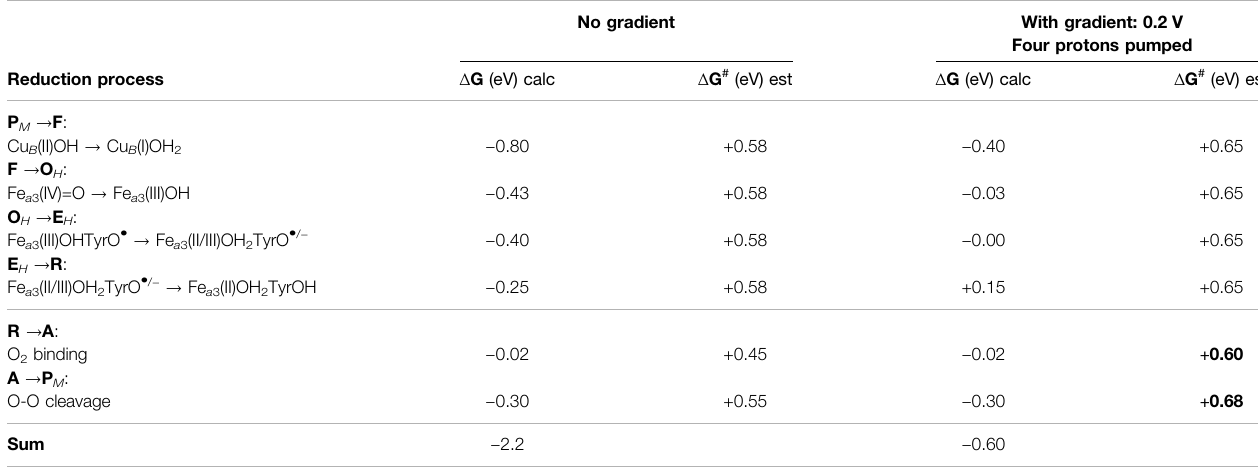
TABLE 2 | Driving forces, Δ G (eV), for the individual reduction steps in the catalytic cycle, as obtained from the present calculations, assuming that the tyrosine is left unprotonated untilthelastreductionstep. Notethatthe fi rstcolumnshowsonlythecofactorreducedineachparticular step,notthefullBNC.Rate-limiting barriers, Δ G # (eV), estimated from experimental information are also given for each step. The effects on the driving forces and the barrier heights of the presence of the electrochemical gradient across the membrane are also given. No